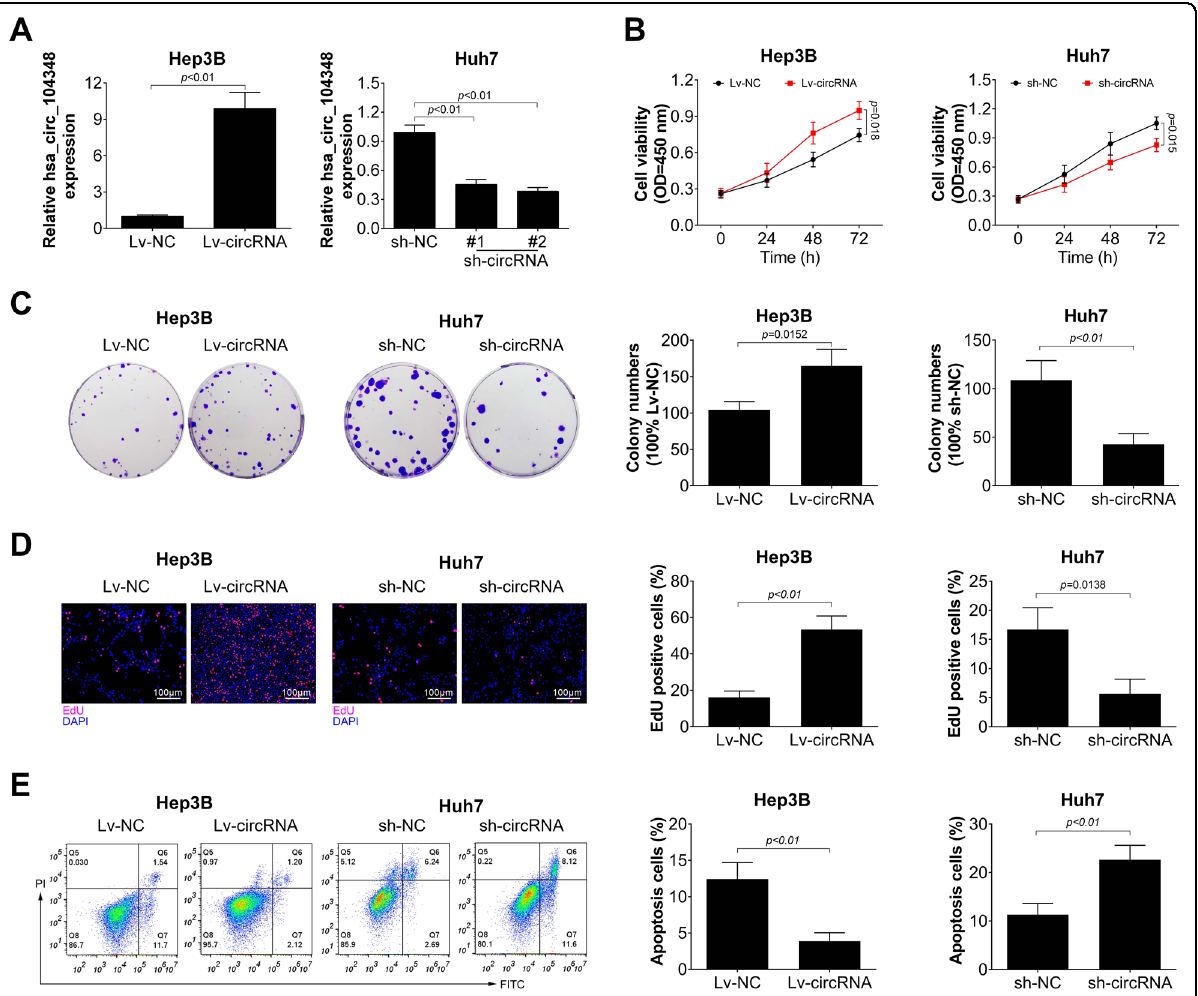
Fig. 2 Has_circ_104348 promoted proliferation, suppressed apoptosis of HCC cells. A The expression of has_circ_104348 was determined by qRT-PCR in has_circ_104348 overexpression or knockdown HCC cells. B – D The effect of has_circ_104348 on HCC cell proliferation was determined by CCK-8 ( B ), colony formation ( C ), and EdU assay ( D ). The apoptosis of HCC cells was measured by staining with Annexin V/PI, followed by FACS analysis. The scale bars were 100 μ m. Data were expressed as mean ±